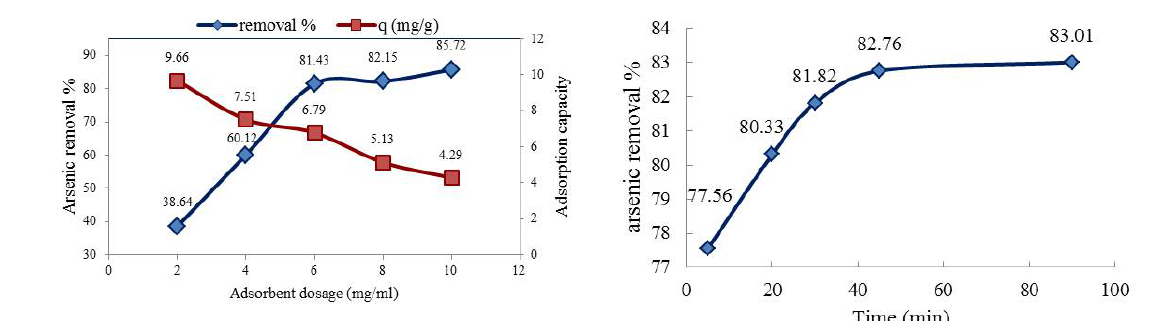
Fig. 9. The effect of initial As(III) concentration on arsenic ef- Fig. 9 The effect of initial As(III) concentration on arsenic efficiencies. ficiencies experimental data to pseudo-first order